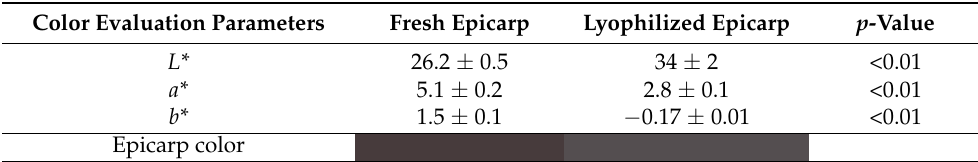
Table 2. Physical parameters (color-CIE L* a* b* ) of the fresh and lyophilized fruit epicarp of Solanum melongena L. (mean ± SD). Color Evaluation Parameters Fresh Epicarp